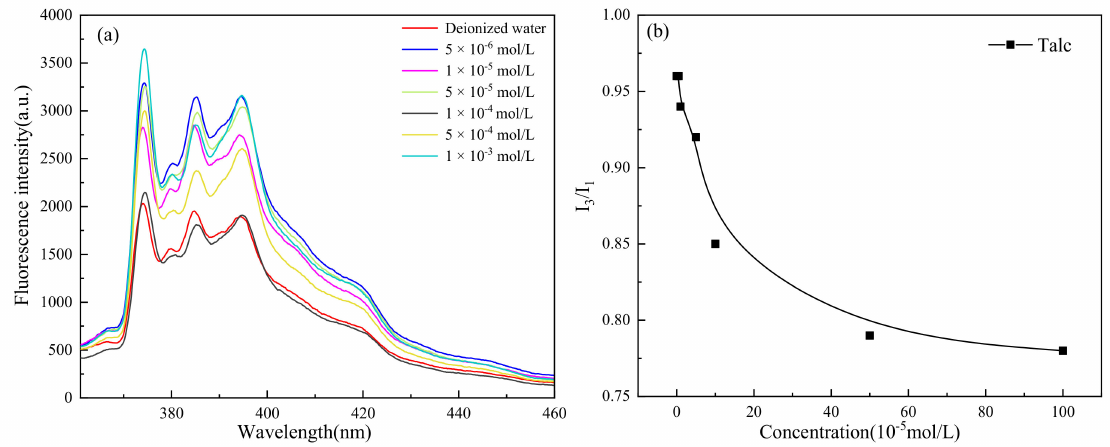
Figure 16. CTAC solutions of different concentrations. ( a ) Pyrene fluorescence spectra of talc. ( b ) I 3 / I 1 values of probe pyrene on talc